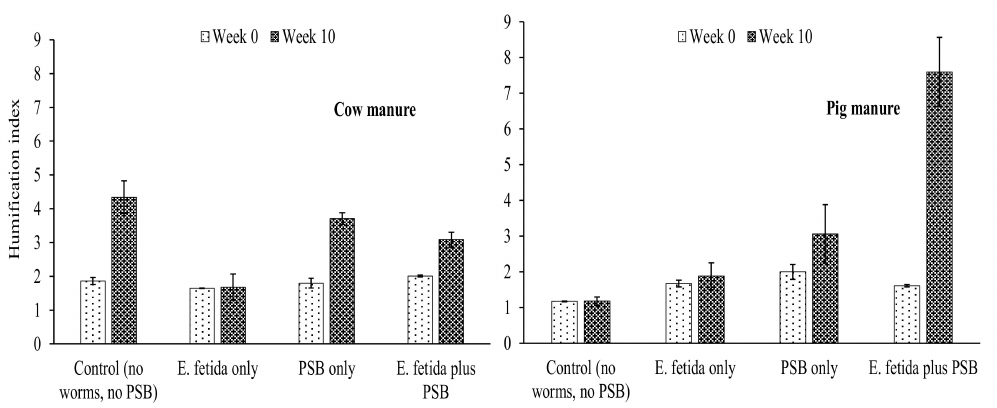
Figure 2. E ff ect of E. fetida and P. fluorescence on the humification index during the vermicomposting of RP-enriched cow and pig manure waste paper mixtures. Error bars indicate standard deviations.